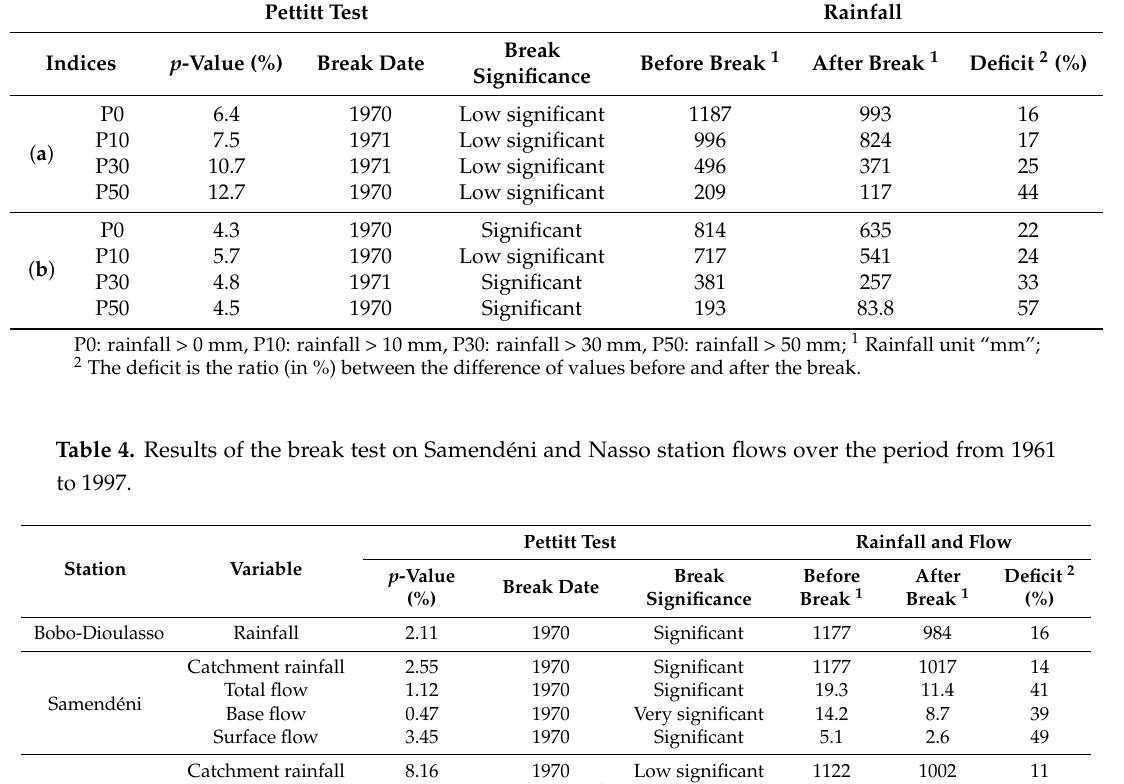
Table 3. Application of Pettitt tests on Bobo-Dioulasso rainfall indices over 1961–2014. ( a ) Annual rainfall; and ( b ) July to September. Pettitt Test